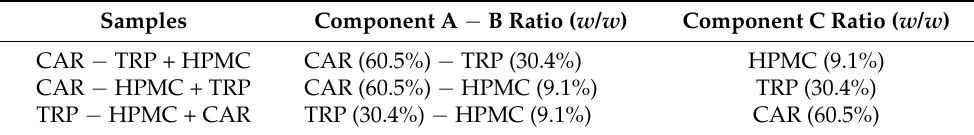
Table 1. Weight ratios of the mixtures for the three A − B + C amorphous systems.